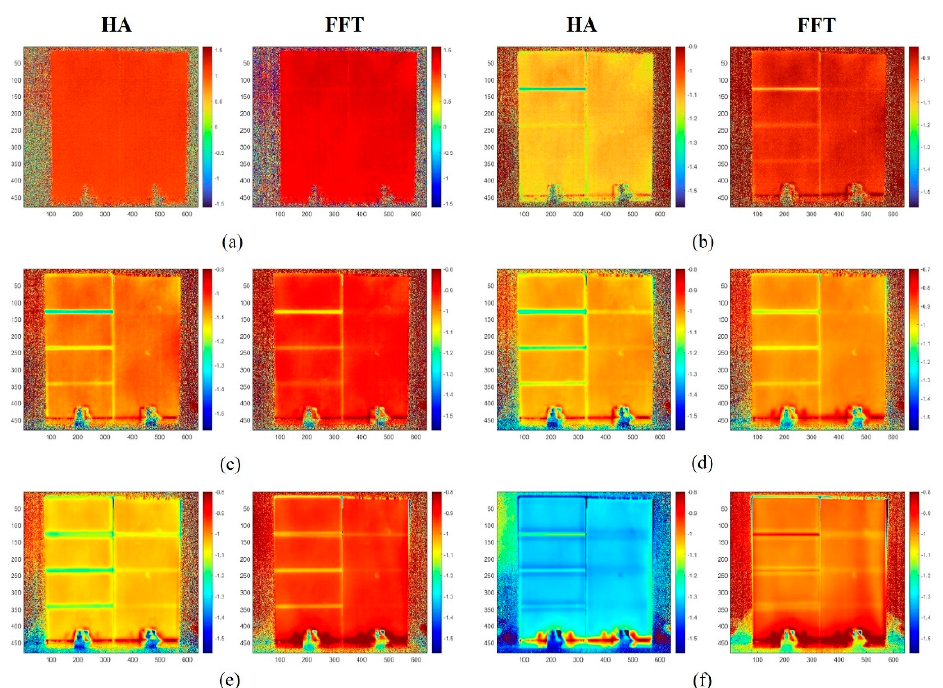
Figure 11. Processed images with HA and FFT algorithms for detecting defects in group 4 of samples at different modulation frequencies: ( a ) 1 Hz, ( b ) 0.2 Hz, ( c ) 0.1 Hz, ( d ) 0.05 Hz, ( e ) 0.03 Hz, and ( f ) 0.01 Hz.